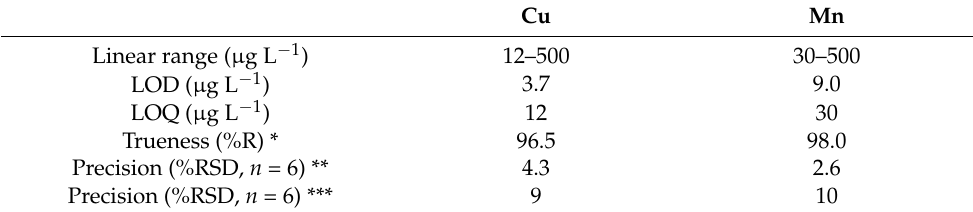
Table 3. Figures of merit for the flow injection (FI) FI-MP OES method.